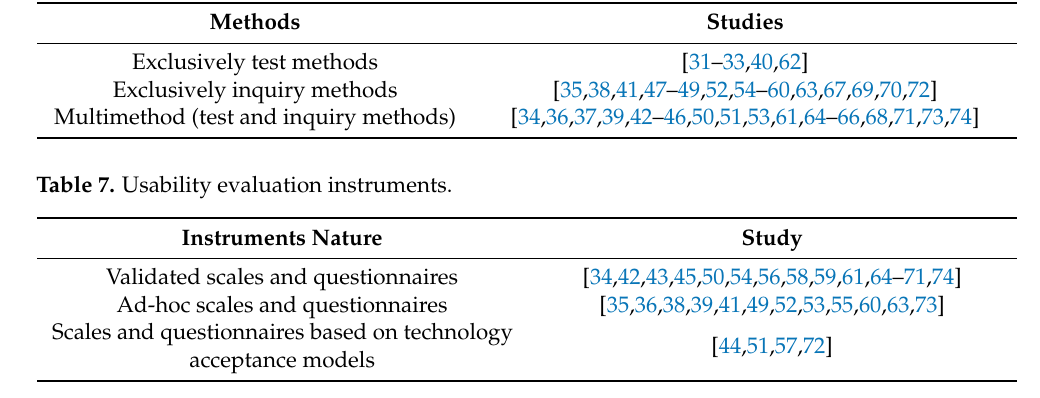
Table 6. Usability evaluation methods.